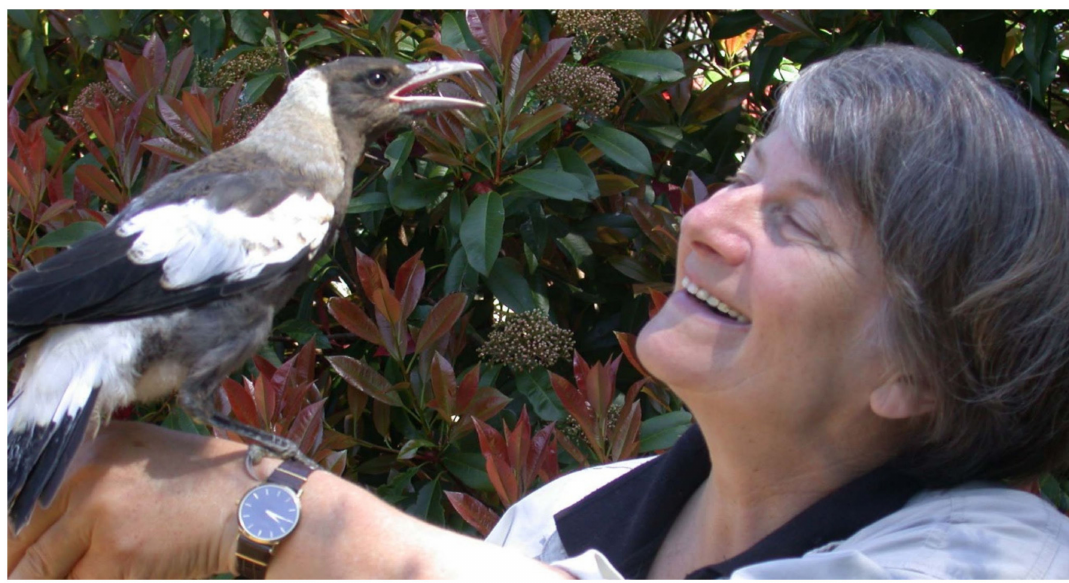
Figure 3. Author interacting with a juvenile magpie many years later but looking very similar to the bird that had such profound influence (Credit: